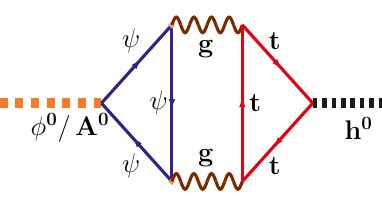
Figure 1. Radiatively generated h 0 (cid:0) (cid:30) 0 ( h 0 (cid:0) A 0 ) mixing diagram induced by the VLQ and top quark at the highly suppressed three loop level.